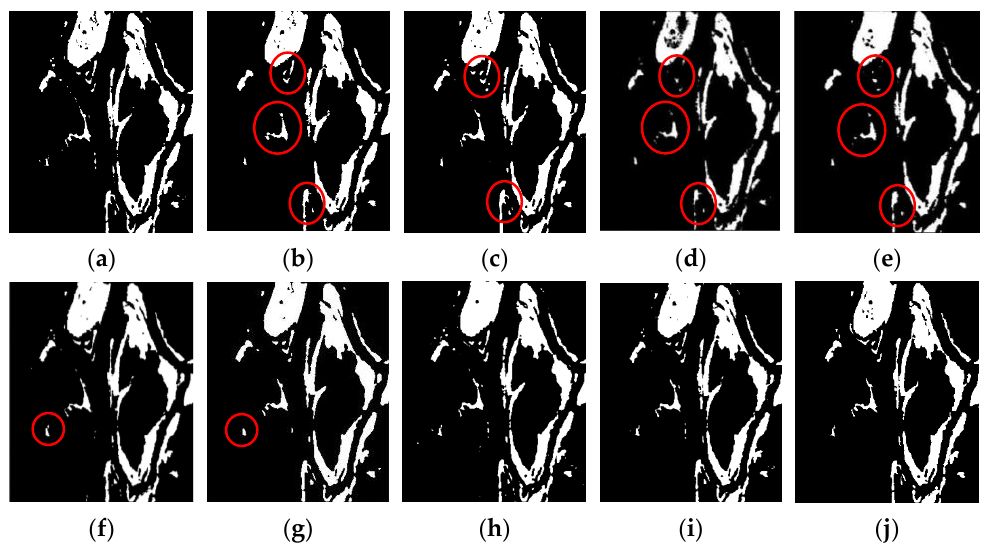
Figure 16. Change detection results of different methods on the Ottawa dataset. ( a ) DBN; ( b ) PCANet; ( c ) CNN; ( d ) LR-CNN; ( e ) DCNet; ( f ) SAFNet; ( g ) RUSACD; ( h ) SSN-Siam-diff (ours); ( i ) SSN-Siam-conc (ours); and ( j ) ground truth. The areas marked by red circles deserve more attention. Table 8. Quantitative results of different methods used for the Ottawa dataset.